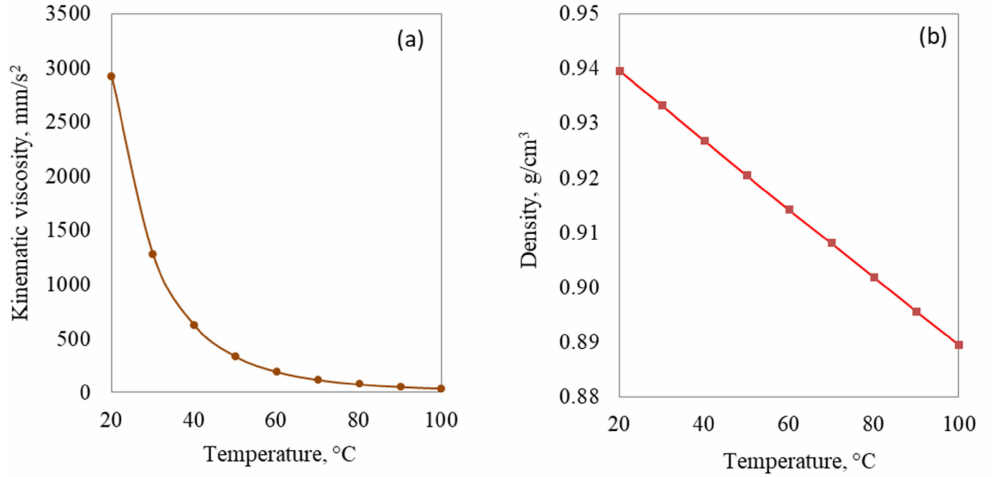
Figure 6. Kinematic viscosity ( a ) and density ( b ) of bis(2-hydroxyethyl)ammonium erucate as a function of